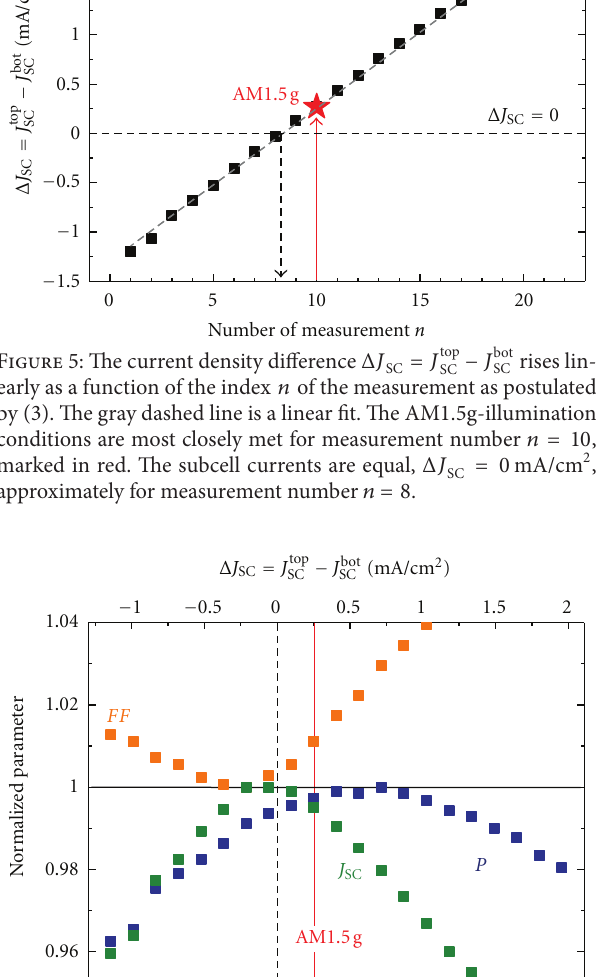
F 6: e normalized solar cell parameters are given for each measurement number. As the measurement number is linearly , the second related to the difference in short-circuit current SC scale is attached above. e sample is slightly mismatched. e 𝑛𝑛𝑛𝑛 (green symbols) is maximized total short-circuit current density Δ𝐽𝐽𝐽𝐽 SC when the subcell currents are approximately equal, close to SC , which does not correspond to AM1.5g-illumination conditions. 𝐽𝐽𝐽𝐽 �nder the same current matching condition the �ll factor (orange 𝑁𝑁 Δ𝐽𝐽𝐽𝐽 symbols) is minimal. e power (blue symbols) peaks for larger 0 . A layer thickness adaption, speci�cally an increase values of SC of the top cell layer thickness, would result in a power Δ𝐽𝐽𝐽𝐽